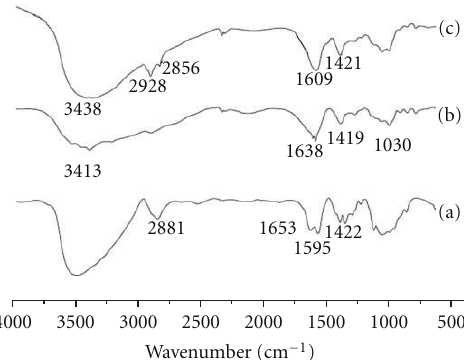
Figure 3: IR spectra of (a) pure chitosan, (b) pure sodium alginate, (c) chitosan/alginate composite